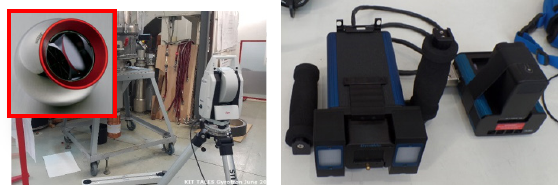
Fig. 6. Laser tracker (and its target), on the left. Camera used for the photogrammetry, on the right